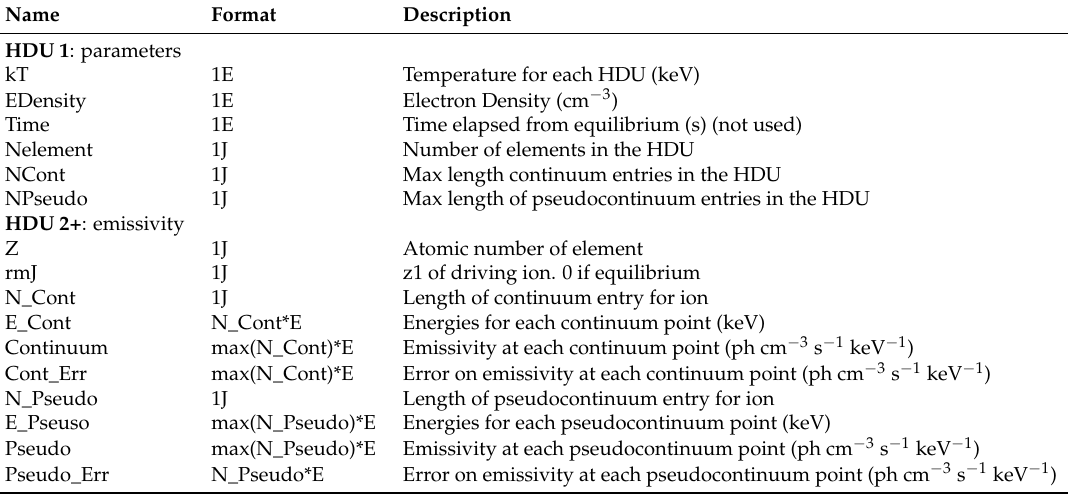
Table A13. APEC Continuum Emission file definition. HDU 1 lists the plasma parameters for each HDU, HDU 2+ are the spectrum for each of those plasmas defined in HDU 1. Note that for the E_Cont, Cont, E_Pseudo, and Pseudo variables, the size of the array is set to the maximum length (N_Cont or N_Pseudo) of every ion in the HDU. However all values above the relevant N_Cont or N_Pseudo are ignored when using the